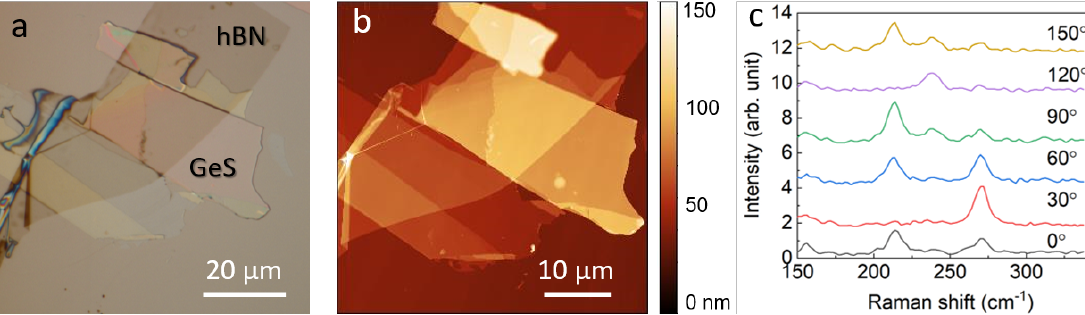
Figure 1. ( a ) Optical image and ( b ) AFM image of the hBN-coated GeS flake showing areas of different thickness. ( c ) Typical angle-resolved Raman spectra of the GeS flake. The relative intensity of the GeS Raman peaks changes as a function of the angle (0–150 degree) between the incident polarized light and the